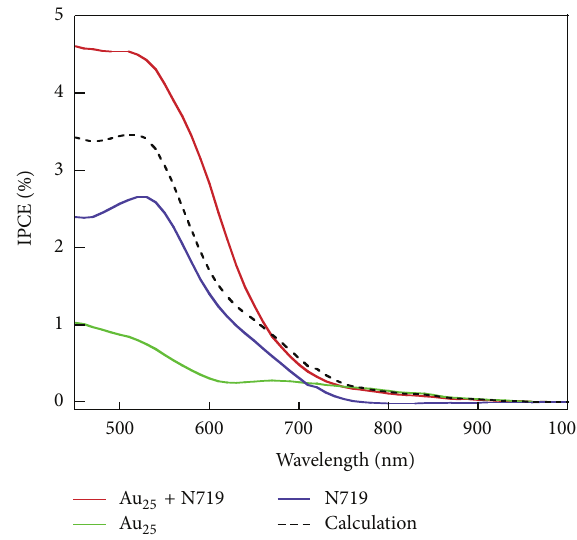
Figure 3: IPCE spectra of TiO 2 photoelectrodes sensitized by glutathione-protected Au 25 clusters, N719 and coadsorbed glutathione-protected Au 25 clusters and N719, and the calculated Au 25 clusters and N719